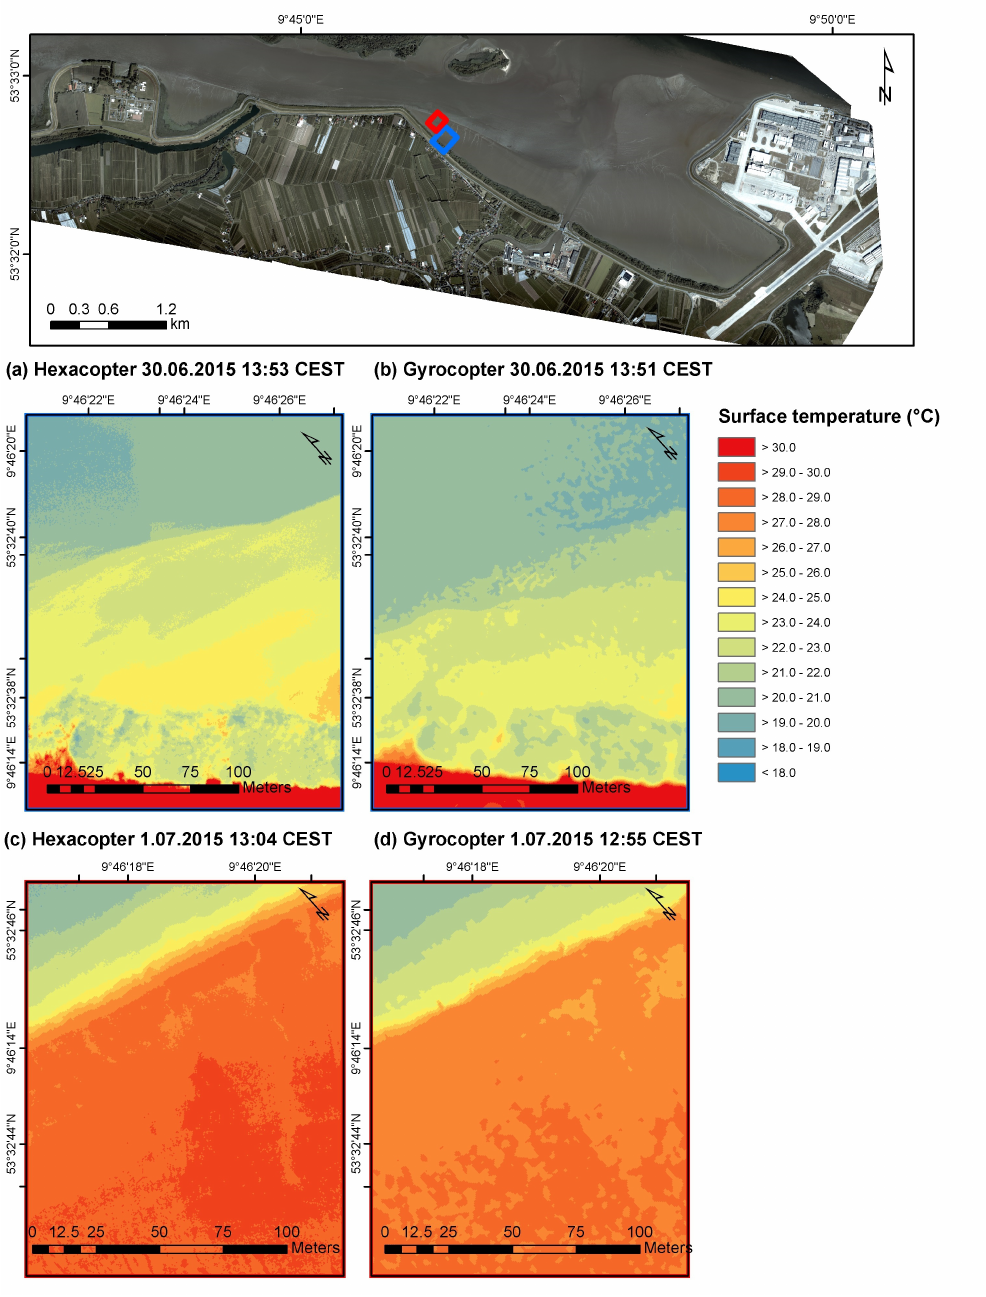
Figure 9. T TIR , hexa and T TIR , gyro after correction and calibration almost at the same overflight times at rising water levels ( c , d ) and high tide ( a , b ) for a section of the hexacopter survey area. The overview is showing the respective areas marked with blue ( a , b ) and red ( c , d )